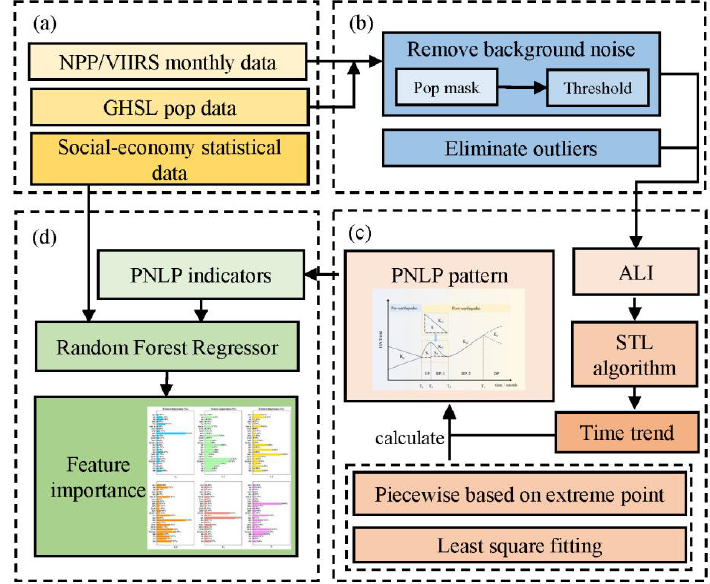
Figure 2. Flowchart. ( a ) Data collection; ( b ) remove the background noise; ( c ) construction and calculation of the post-earthquake night-time light piecewise (PNLP) pattern; ( d ) the analysis of feature importance of PNLP indicators based on random forest